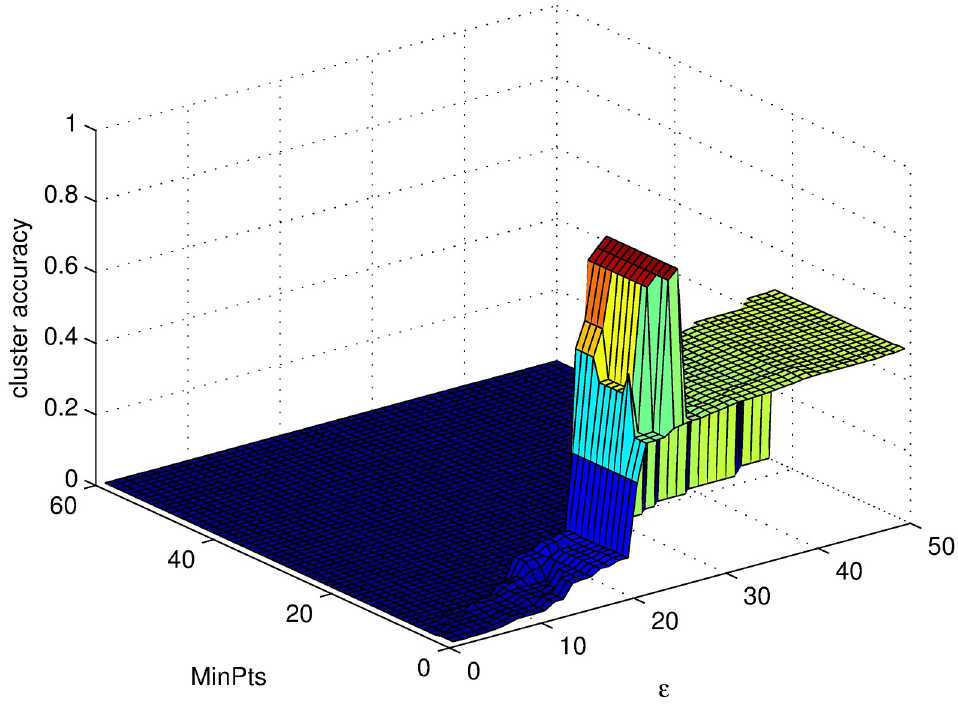
Fig 7. The cluster accuracy of different parameter values in the banana database obtained by DBSCAN-CPPI.